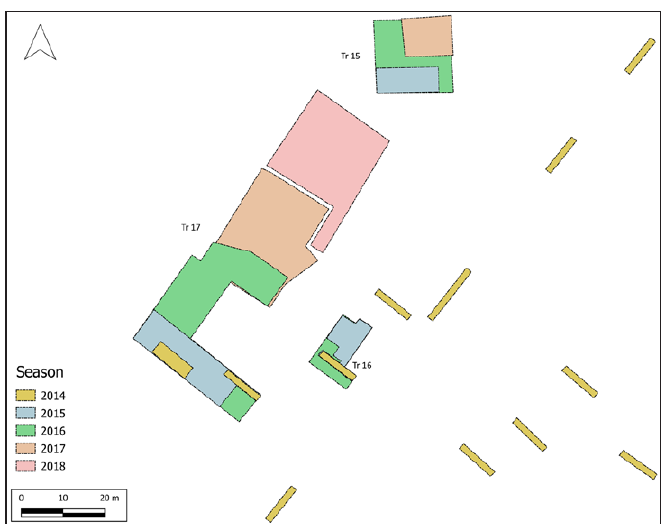
Figure 3: Plan showing all the excavation trenches and areas up to the end of 2018. [Rob Kaleta/Downley Project].